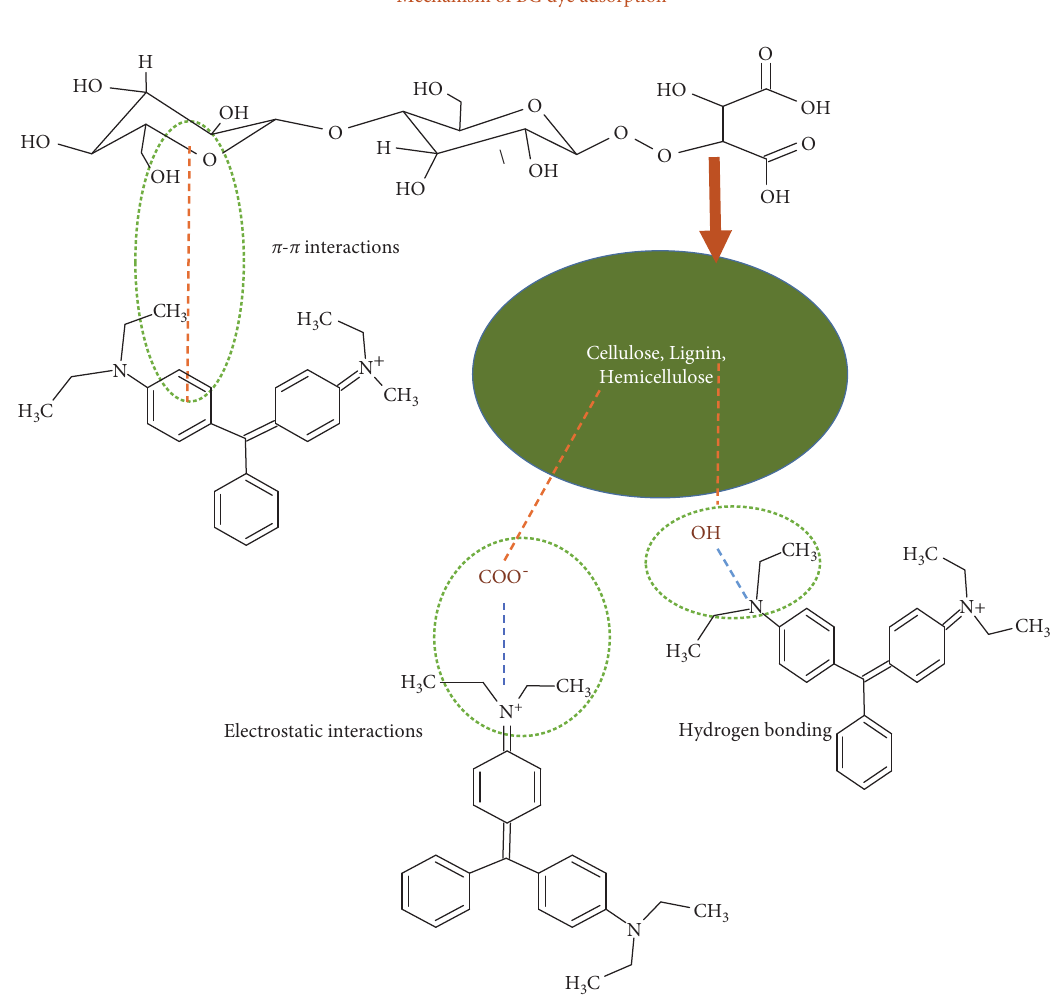
Figure 7: Proposed mechanism for BG dye adsorption.